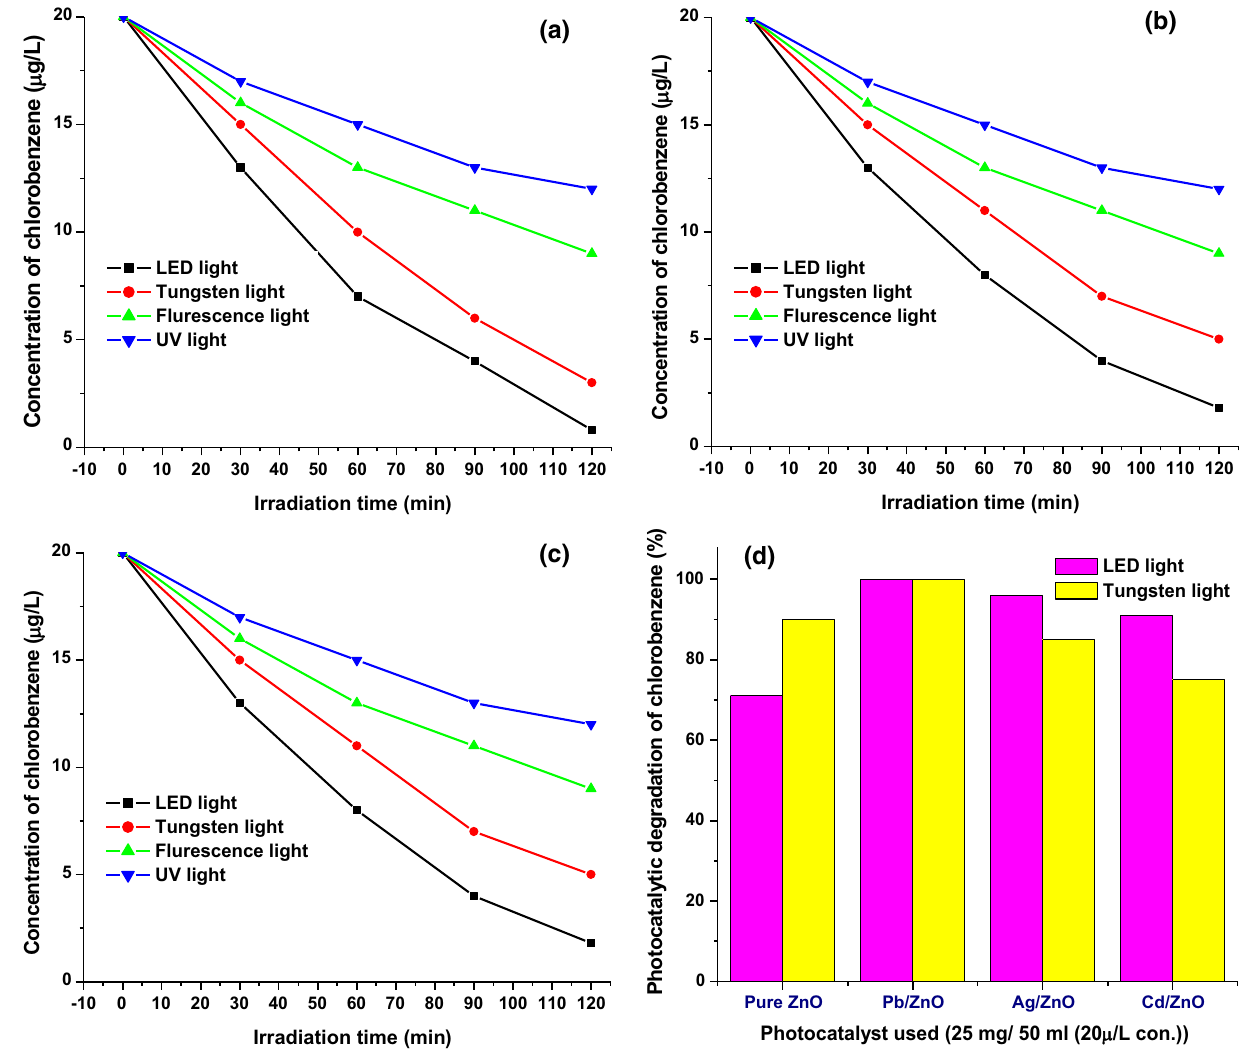
Fig. 10 Photocatalytic degradation of chlorobenzene using a Ag/ZnO; b Cd/ZnO; c Pb/ZnO and d Degradation efficiency (in %) of chloroben- zene using pure ZnO and modified ZnO nanoparticles under LED and tungsten light